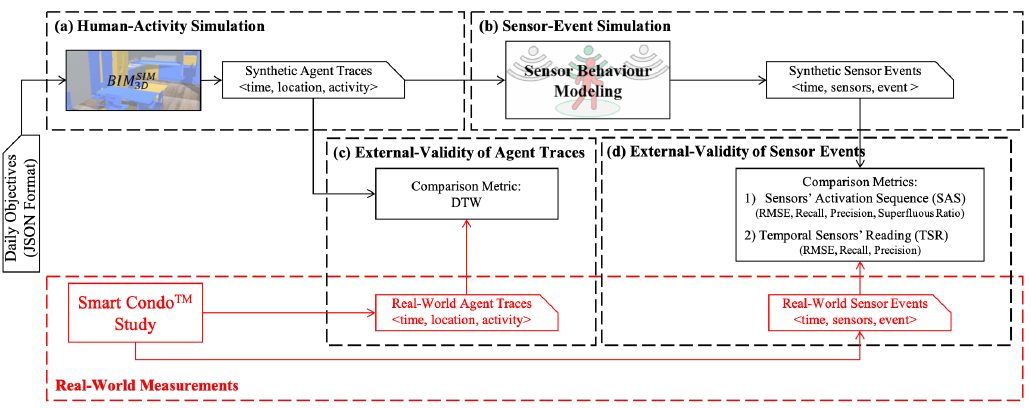
Figure 1. The software architecture of the SIM SIS toolkit. Real-world measurements module is shown in red